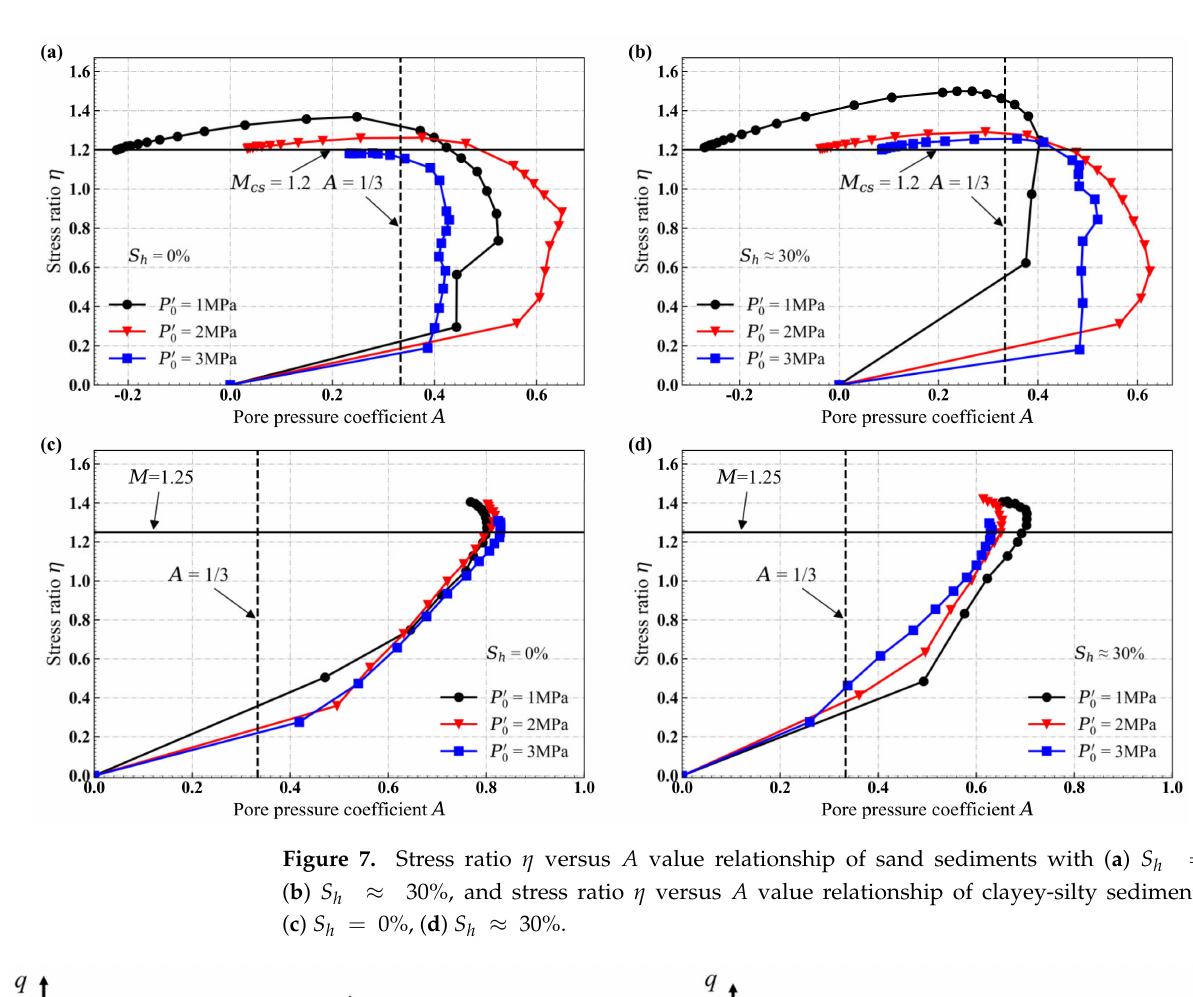
Figure 7. Stress ratio η versus A value relationship of sand sediments with ( a ) S h = 0%, ( b ) S h ≈ 30%, and stress ratio η versus A value relationship of clayey-silty sediments with ( c ) S h = 0%, ( d ) S h ≈ 30%.